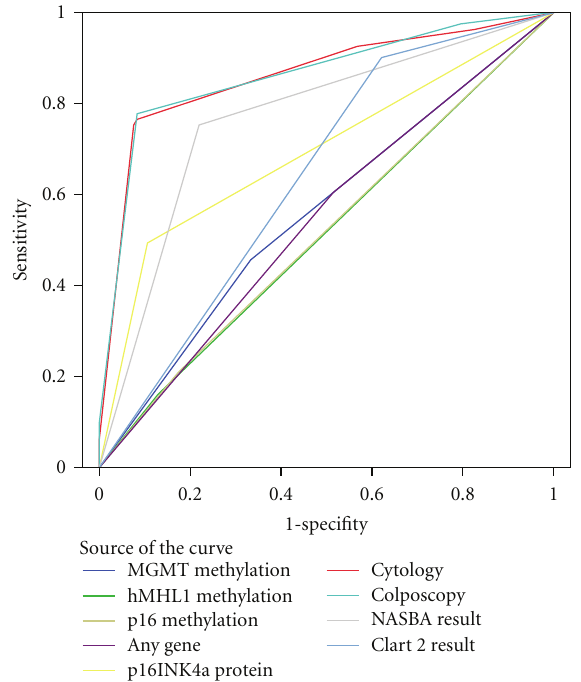
Figure 2: ROC curve analysis. Diagonal segments are produced by